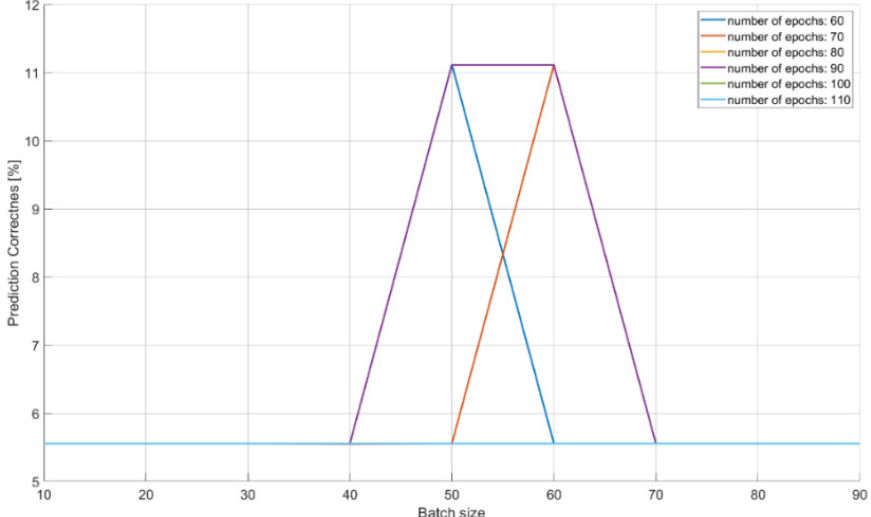
Figure 13. Effectiveness of radar signals recognition on the basis of the PD parameter in the function of the changes in the size of the training dataset and the number of iterations in the training algo- rithm.